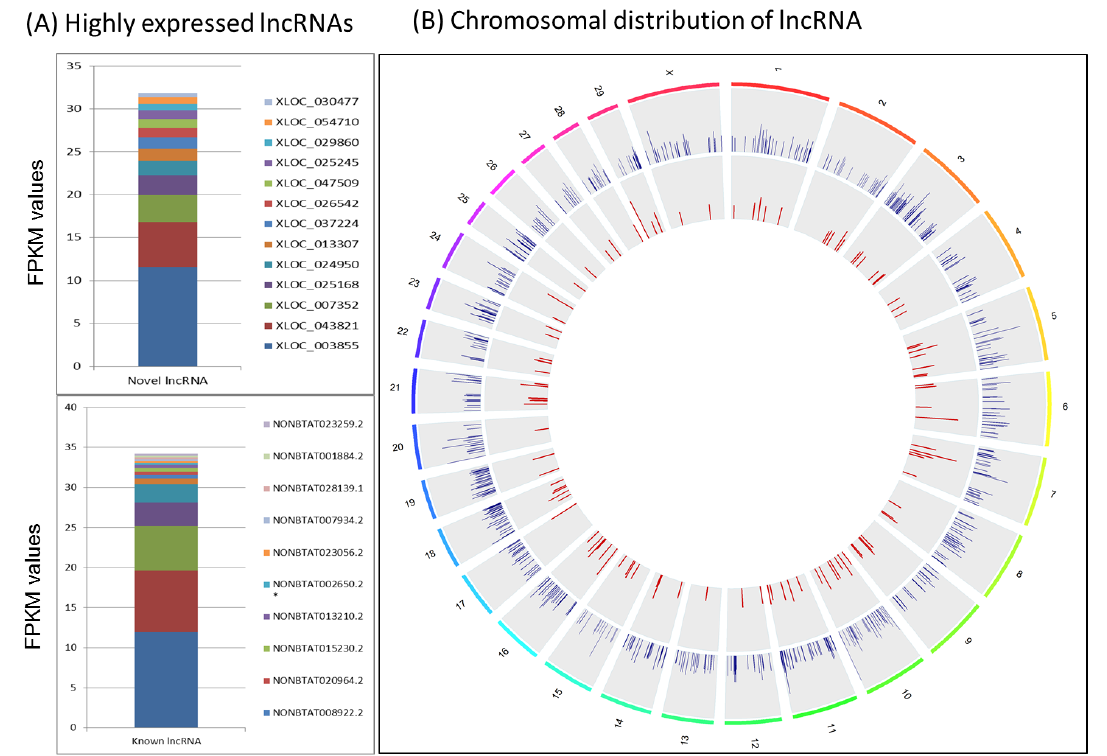
Figure 1. ( A ) Fifteen known and 13 novel highly expressed lncRNAs in the bovine mammary gland. FPKM values ranged from 0.55 to 11.56 or 0.21 to 11.93 for novel and known highly expressed lncRNAs, respectively. ( B ) Intuitive map of lncRNA distribution across bovine chromosomes (outermost circle, different colors). The inner circle (blue lines) represents novel lncRNAs and the innermost circle (red lines) represents known lncRNAs. The height of the line is proportional to the expression level (FPKM) and only those with FPKM > 0.02 are shown.